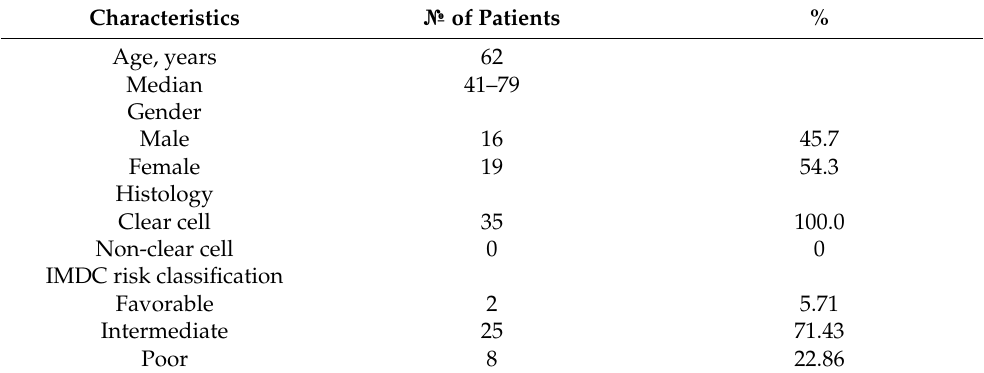
Table 1. Baseline patient characteristics.